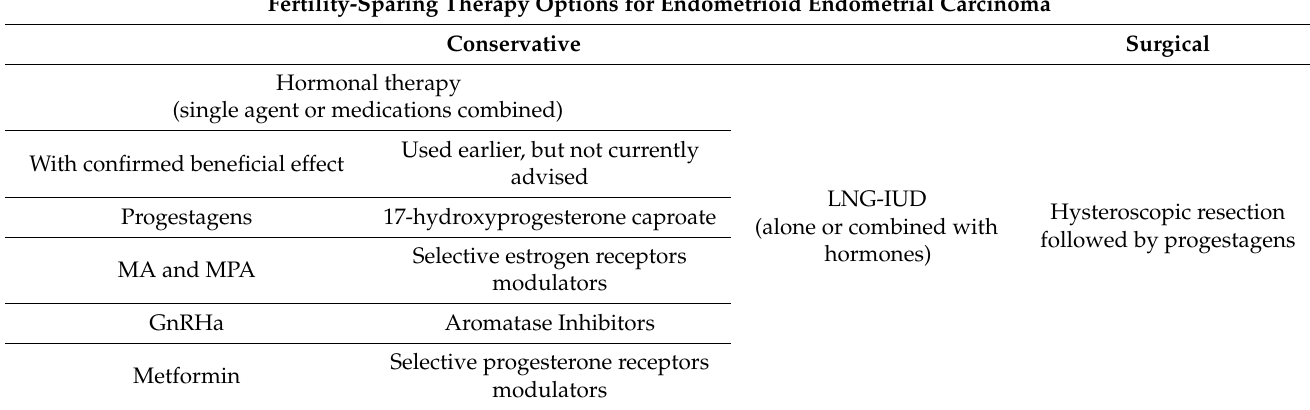
Table 2. Fertility-sparing therapy options for endometrioid endometrial carcinoma. Fertility-Sparing Therapy Options for Endometrioid Endometrial Carcinoma